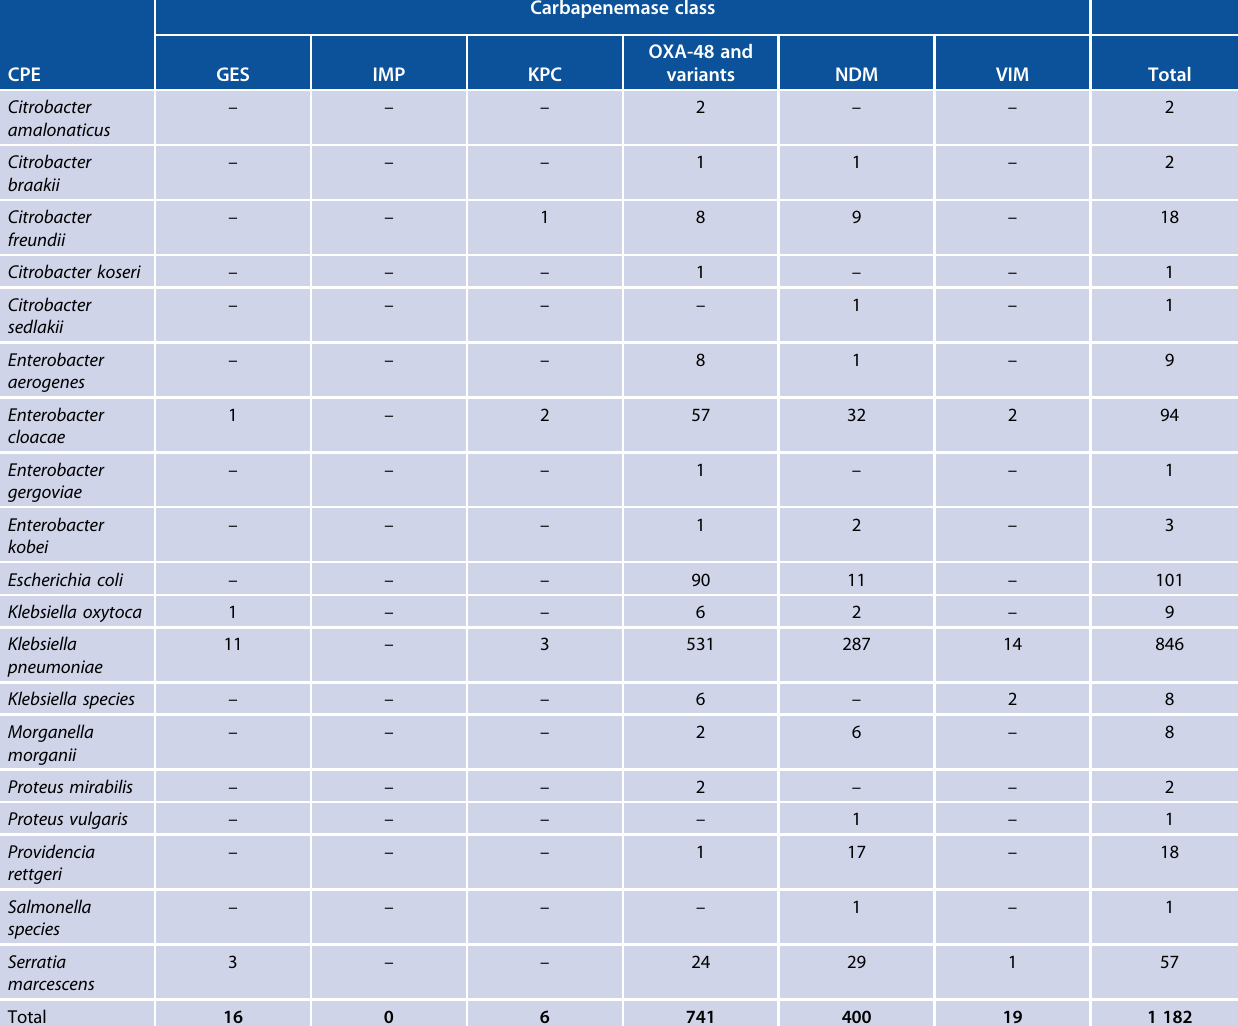
Table 13: Total number of confirmed Carbapenemase-producing Enterobacteriaceae, January 1, 2016 to December 31, 2016